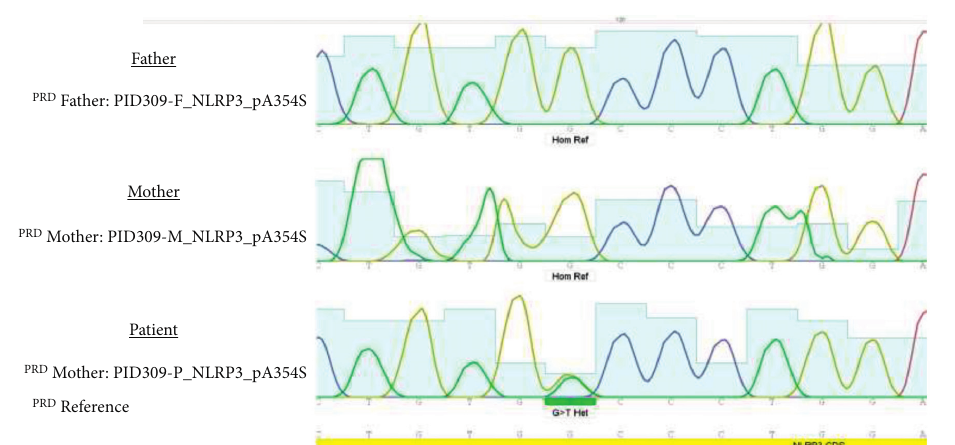
Figure 2: Sequence electropherogram of NLRP3 (c.G1060 T). The parents were homozygous for wild-type allele, but the patient was heterozygote for mutant